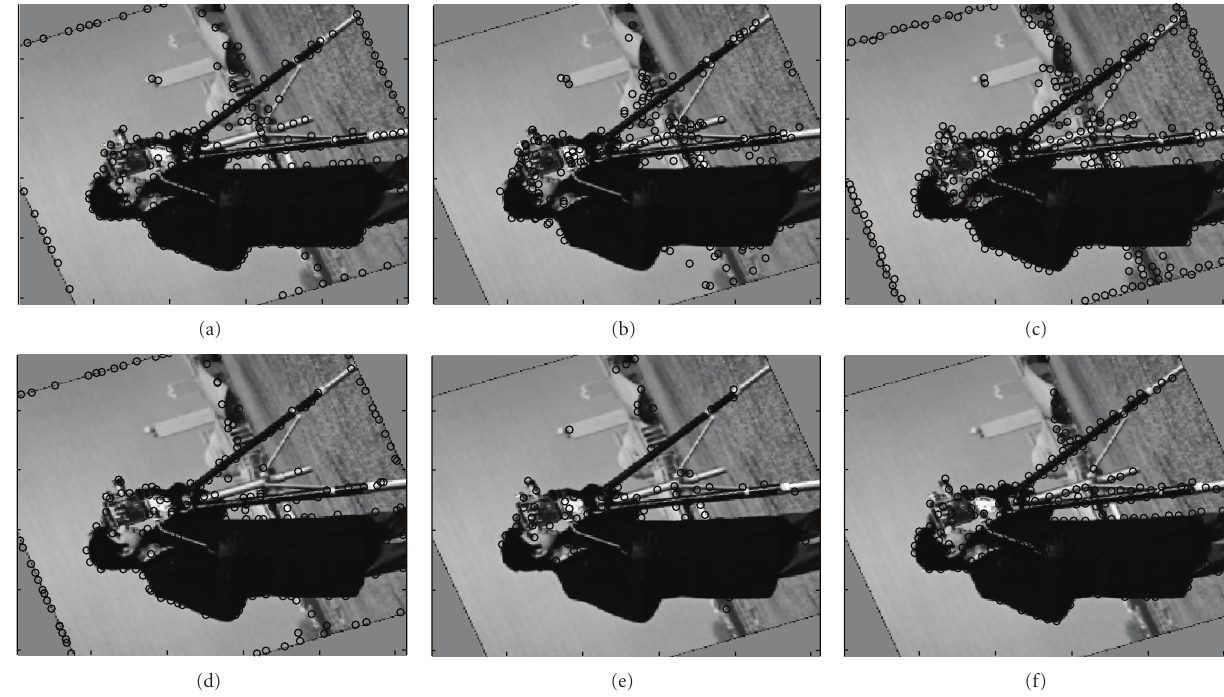
Figure 6: Feature points detected in 110 ◦ rotated image by (a) Harris’ method, (b) Lowe’s method, (c) Tomasi’s method, (d) Loupias’ technique, (e) Yeh’s algorithm, and (f) proposed technique.